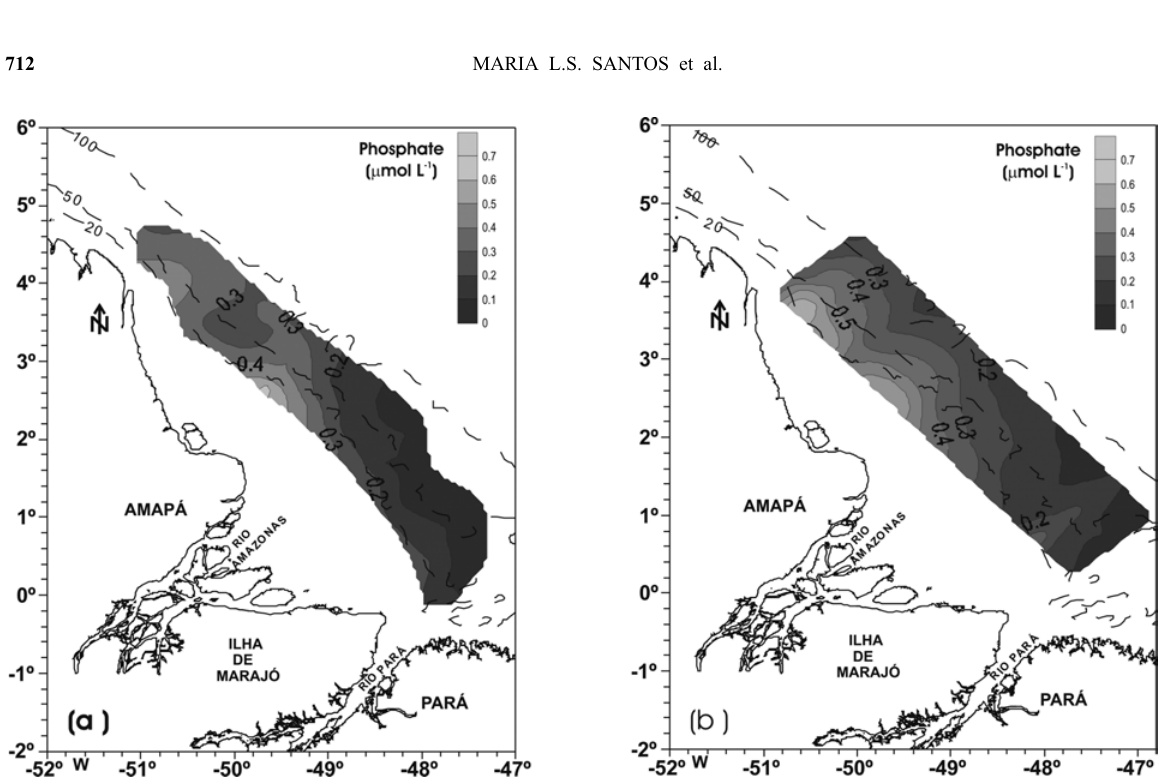
Fig. 7 – Distribution of the superficial concentration of the phosphate during Operation Norte IV (falling discharge of the Amazon River): (a) REVIZEE data; and (b) MACC-2D model results.